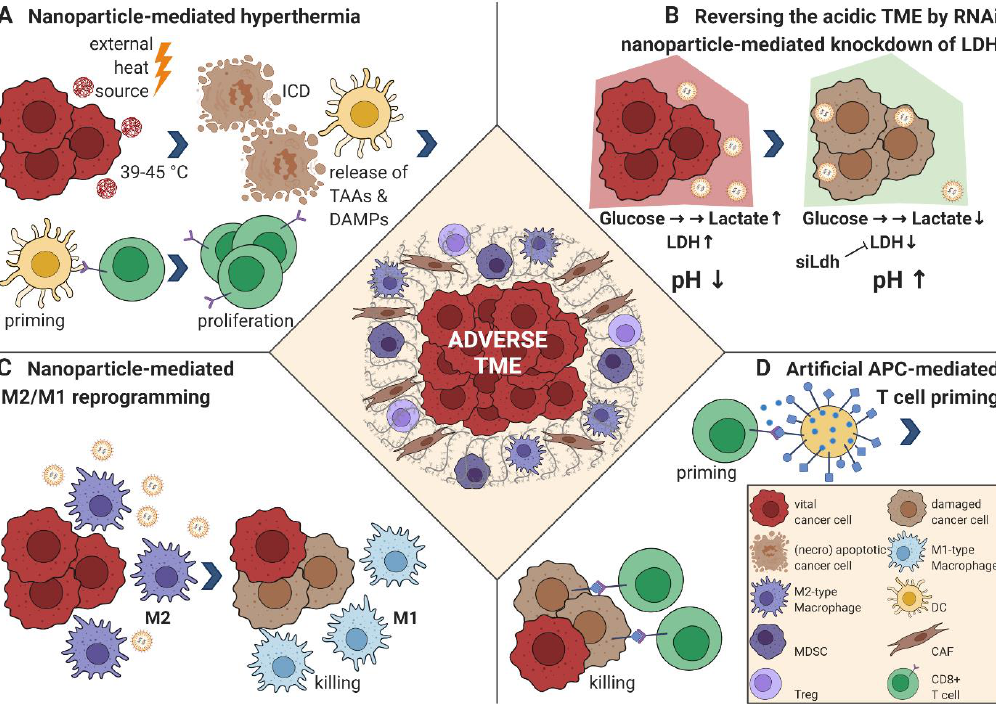
Figure 2. Strategies to reprogram the suppressive TME. ( A ) Targeted nanoparticles are administered and home to the TME. Upon external irradiation with an energy source (light, magnetic field, radiofrequency application), the surrounding tissue is heated to 39–45 °C, which induces cell stress that triggers the unfolded protein response (UPR) [79]. The UPR can lead to immunogenic cell death (ICD); the release of tumor-associated antigens (TAAs) and danger-associated molecular patterns (DAMPs); and activation of myeloid cells, especially dendritic cells (DCs), that prime T cells to initiate an antigen-specific adaptive anti-cancer immune response executed mainly by CD8 + cytotoxic T cells [70]. ( B ) RNA-binding nanoparticles are loaded with siRNA targeting lactate dehydrogenase A (LDH). The functional knockdown of LDH minimizes lactate production, reversing the acidic pH of the TME, with a subsequently enhanced immune response and a reduced tumor neoangiogenesis [75]. ( C ) Nanoparticles for TAM-specific delivery of TLR agonists [80,81] or small molecules inhibiting colony-stimulating factor 1 receptor (CSF-1R) [82] can shift the immune-suppressive M2 phenotype into an inflammatory M1 phenotype promoting CD8 + T cell mediated killing of cancer cells. ( D )